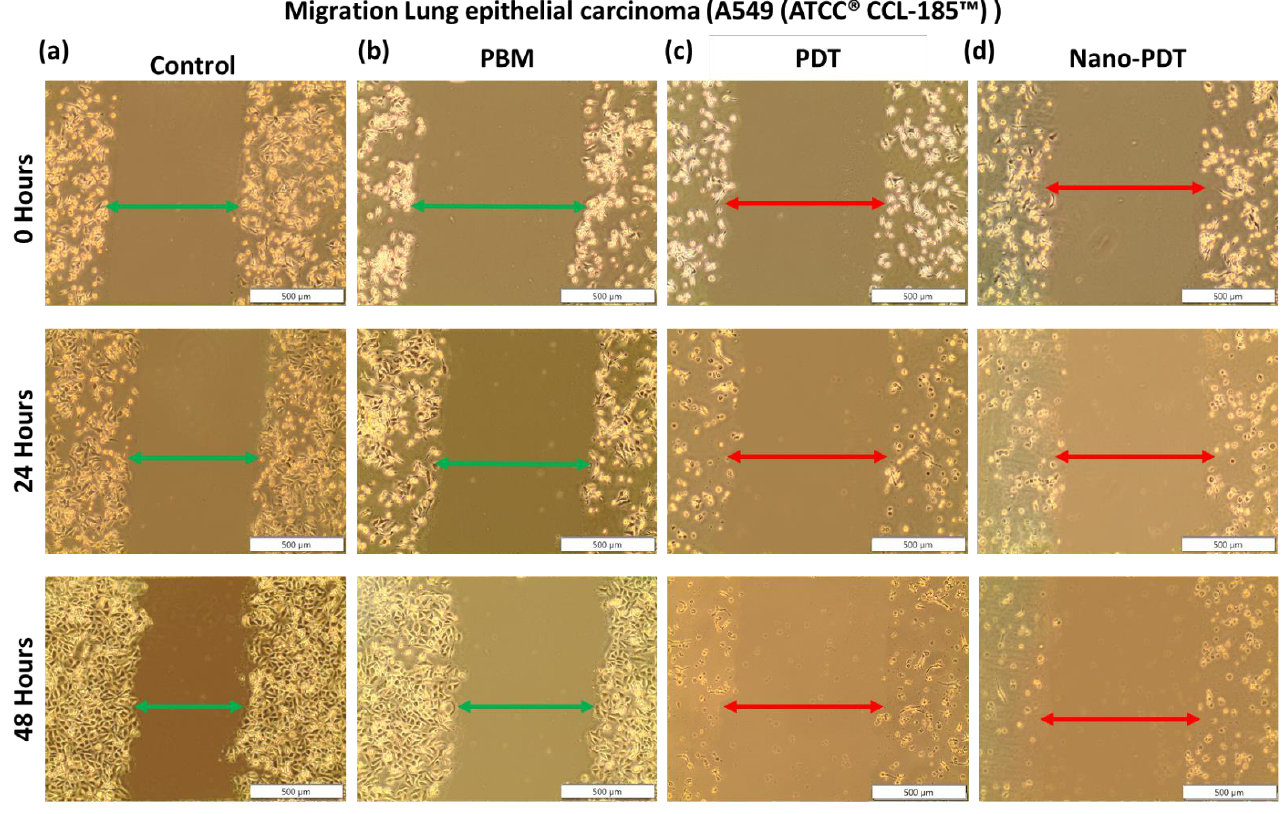
Figure 3. Migration morphology of lung epithelial carcinoma cells (A549) at 0, 24, and 48 h post- PDT treatment: ( a ) Control cells receiving no treatment. ( b ) Cells receiving PBM of 10 J/cm 2 with a wavelength of 660 nm. ( c ) Cells receiving PDT treatment using 20 µM AlPcS 4 Cl and 10 J/cm 2 irradiation. ( d ) Cells receiving nanoPDT treatment using the AlPcS 4 Cl-goldnano bioconjugate.